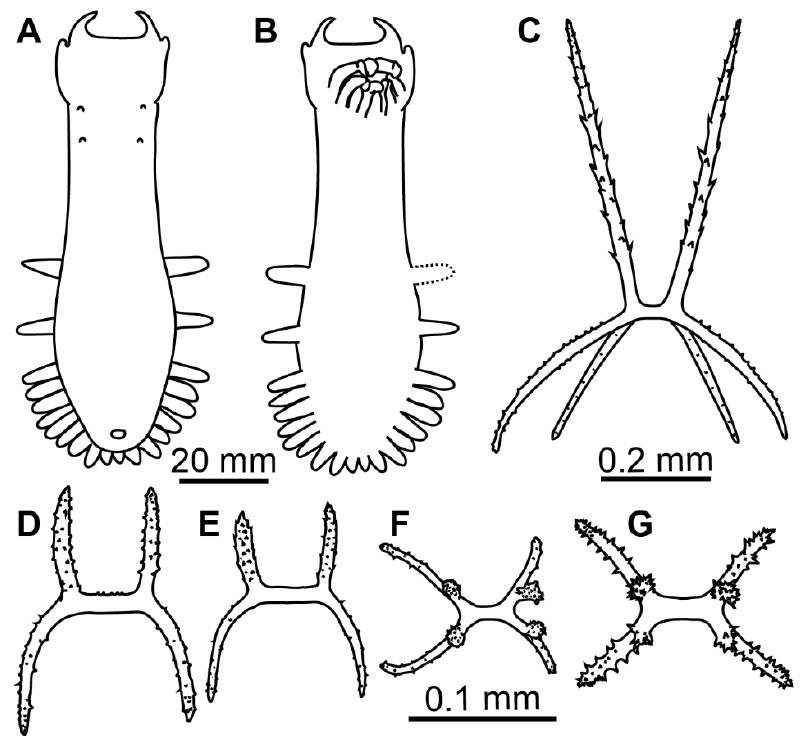
Figure 8. Peniagone vitrea ( A – C ) and Peniagone sp. “miniatura” ( D – G ). ( A – C ), RV Vityaz , St. 5603. ( A , B ) dorsal and ventral view; ( C ) dorsal ossicle, scale 0.2 mm. ( D – G ) RV Sonne , St. 6-9, dorsal ( D – F ) and ventral ( G ) ossicles, scale 0.1 mm.